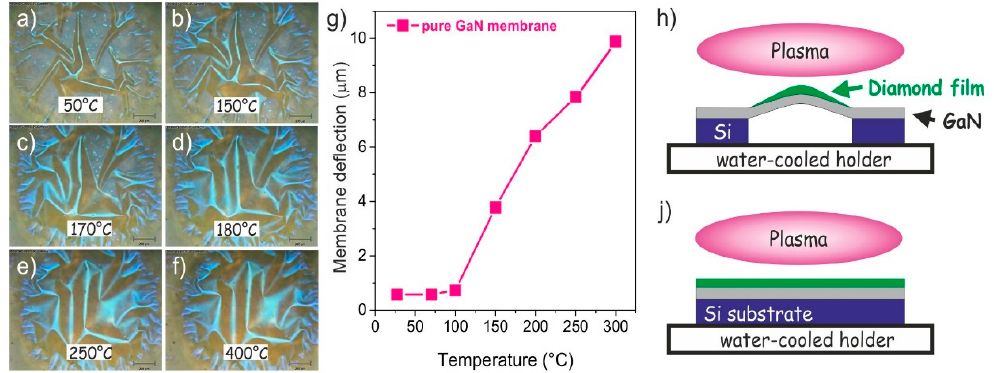
Figure 1. ( a – f ) Optical photos of diamond-coated GaN membranes at different temperatures. ( g ) Deflection of the pure GaN membrane as a function of temperature. Schematic models of top-side diamond deposition on the GaN membrane ( h ) and solid GaN/Si substrate ( j